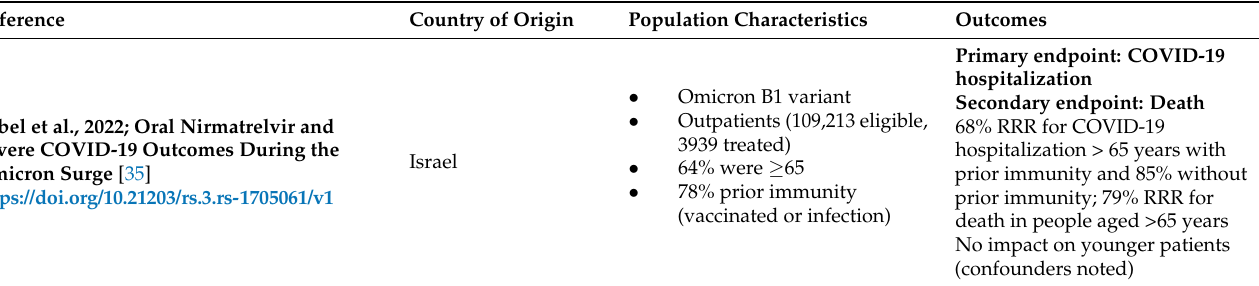
Table 2. Real-world data on the effectiveness of